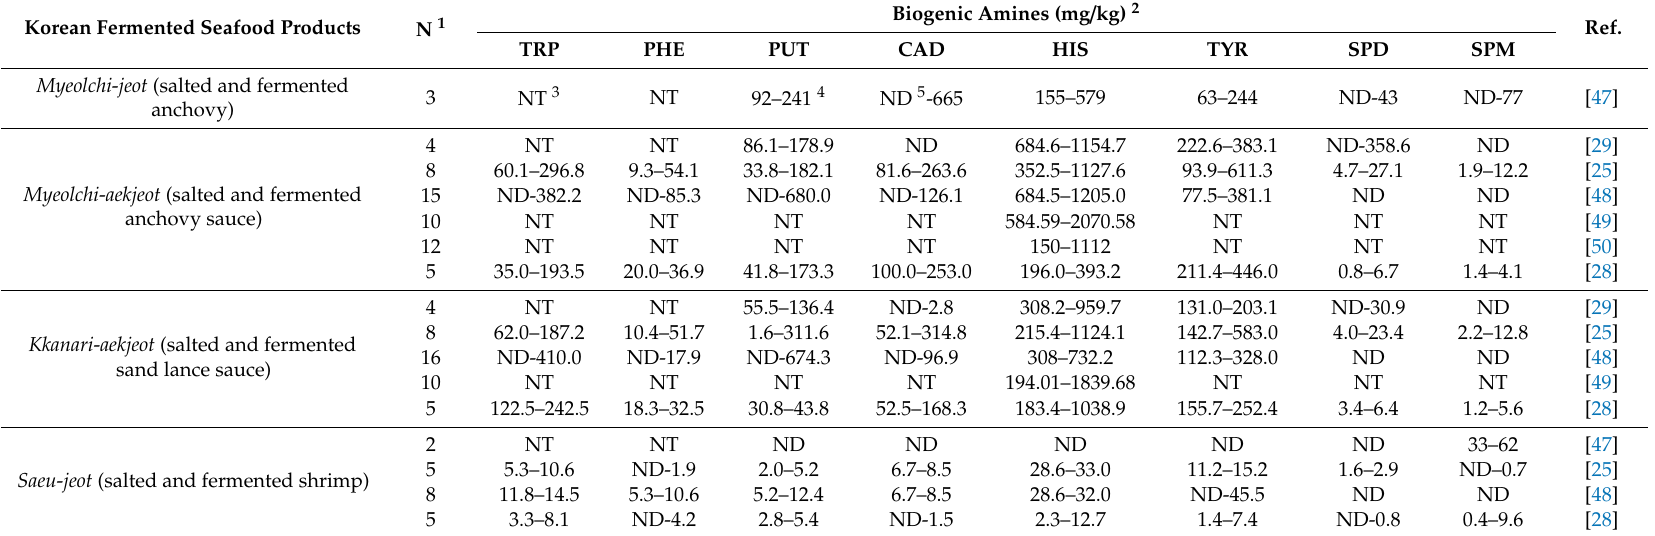
Table 2. Biogenic amine content of Korean fermented seafood